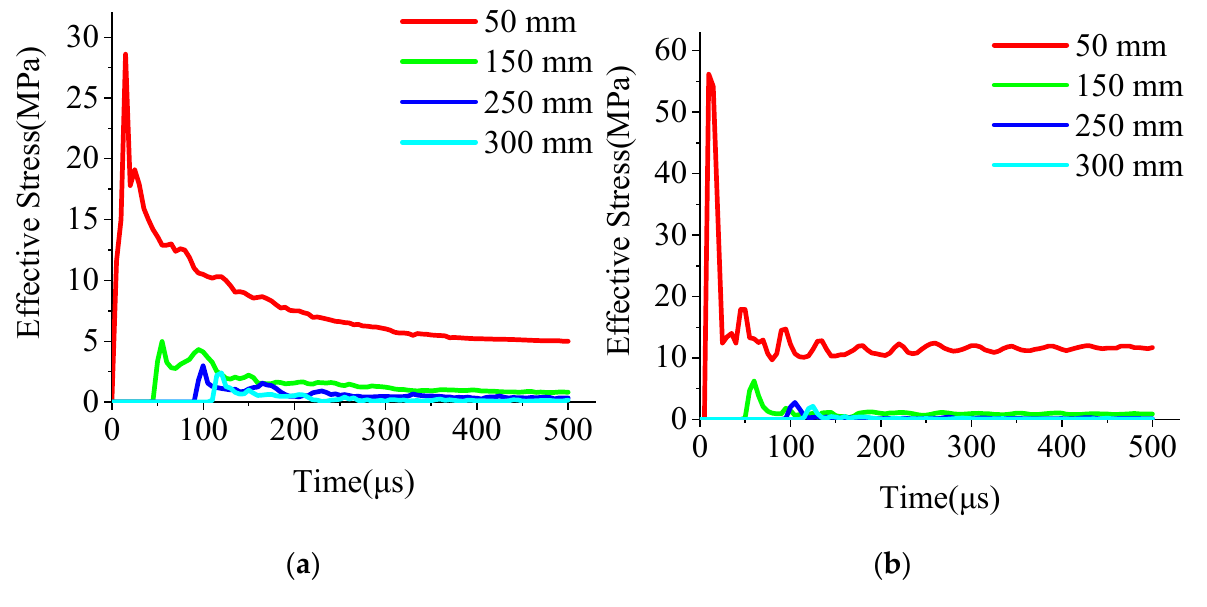
Figure 6. Effective stress time history curve of each measurement point under different blasting methods: ( a ) HPAB; ( b ) explosive blasting.